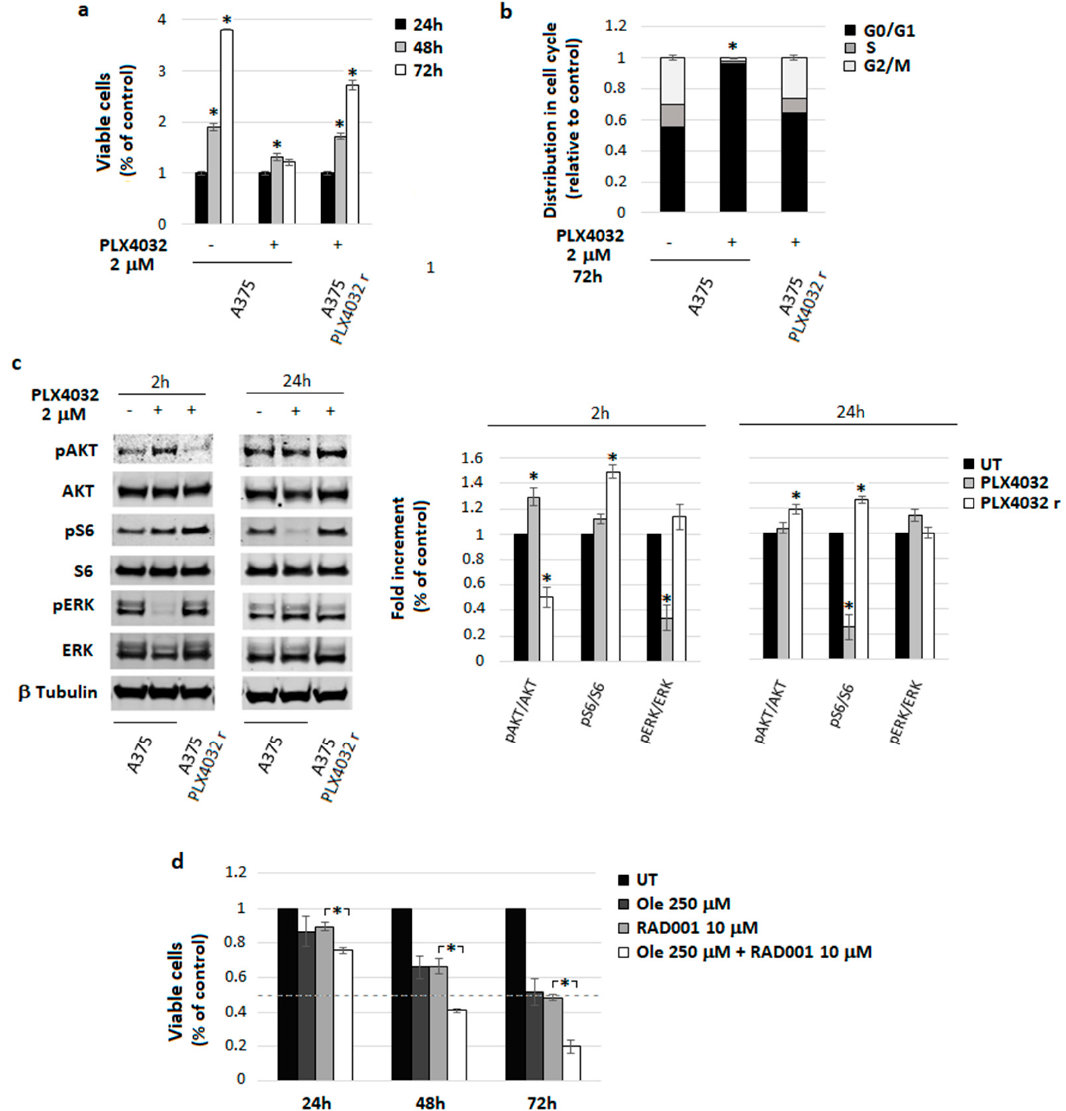
Figure 4. Characterization of A375 melanoma cells resistant to PLX4032 and effect of Ole-RAD001 treatment on these cells. ( a ) Cell viability evaluated via MTT assay. Significance refers to the untreated control. ( b ) Cell cycle distribution analyzed using FACS. * p ≤ 0.05 vs. UT. ( c ) Representative Western blot of pAKT, AKT, pS6, S6, pERK, and ERK in cells treated with PLX4032 2 µ M ( ≈ 980 ng/mL) for 2 or 24 h. ( Right ) Densitometric quantification of the ratio of pERK/ERK, pAKT/AKT, and pS6/S6 relative to β -Tubulin expression. * p ≤ 0.05 refers to UT. ( d ) Dose–time response evaluated on A375 cells that were PLX4032-resistant via MTT assay. * p ≤ 0.05 refers to Ole-RAD001 treatment vs. RAD001